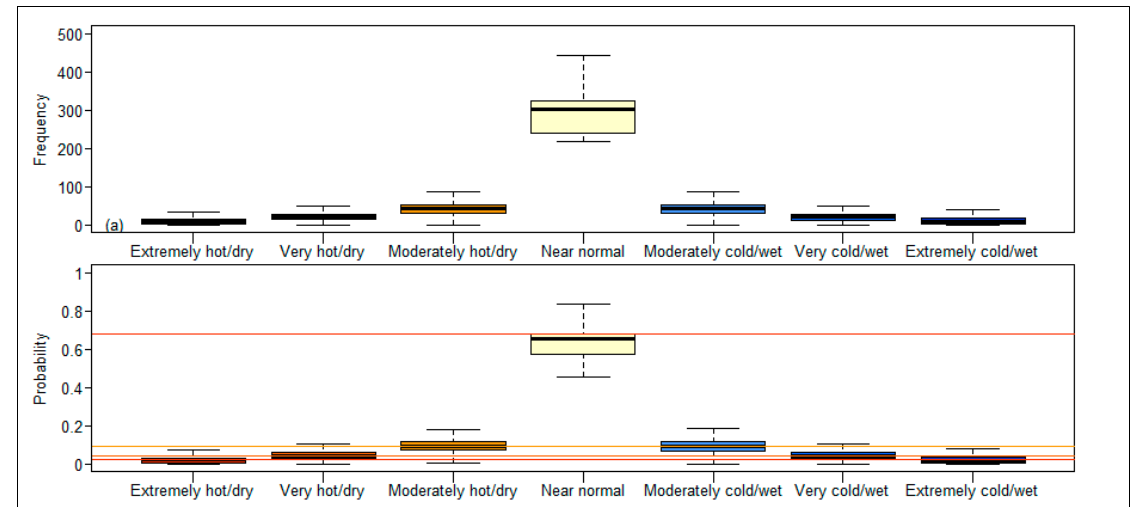
Figure 14. Occurrence frequency of climatic conditions over West Africa (1980–2020) .